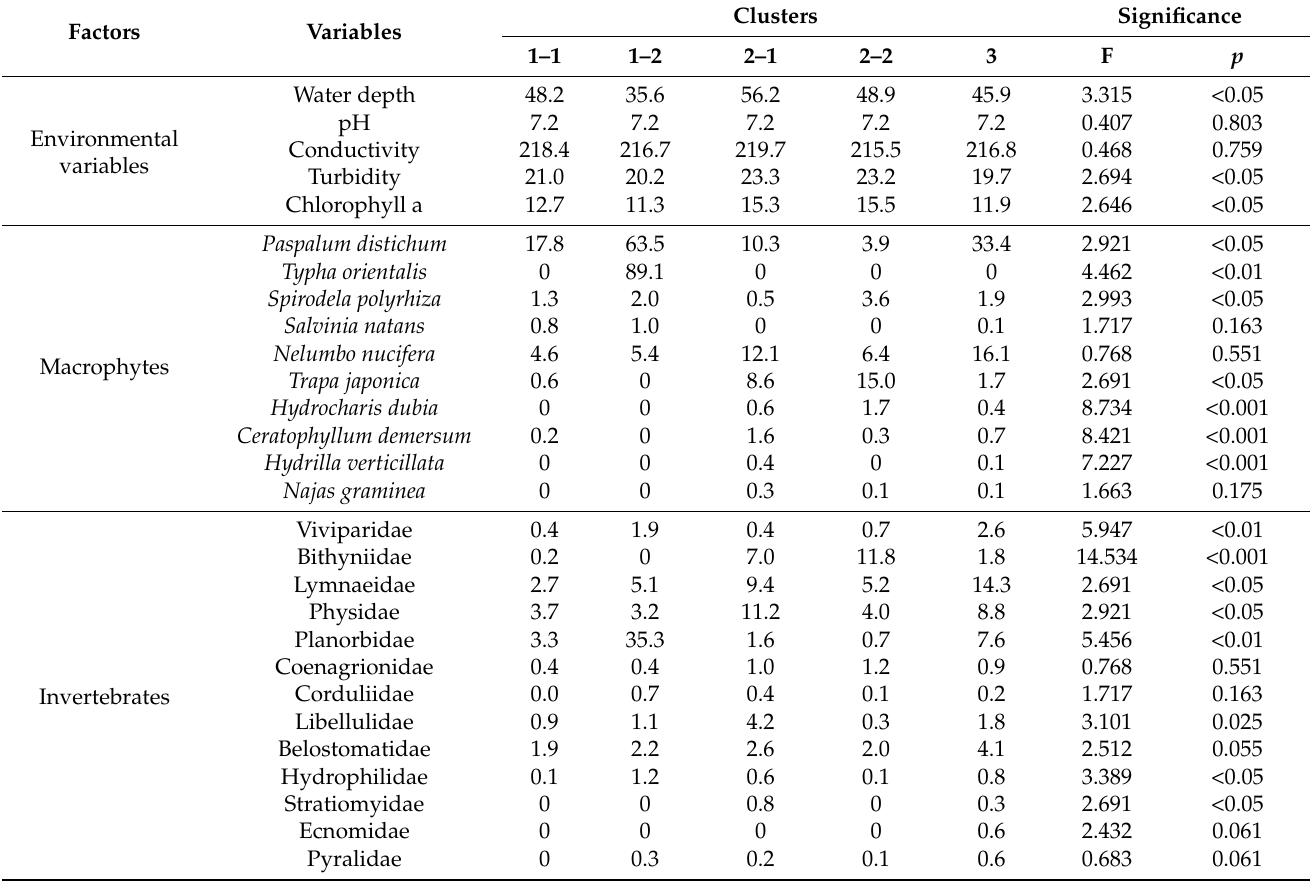
Figure 3. Clustering through data learning by the self-organizing map. ( a ) U-matrix, ( b ) clustering result, and ( c ) hierarchical dendrogram. Cl., cluster. The darker the color of U-matrix (i.e., dark gray to black), the higher the difference between nodes (hexagons). Table 2. Data configuration for the self-organizing map and averages of input variables for each of the clusters. Significant differences between clusters were based on one-way ANOVA (df = 4).